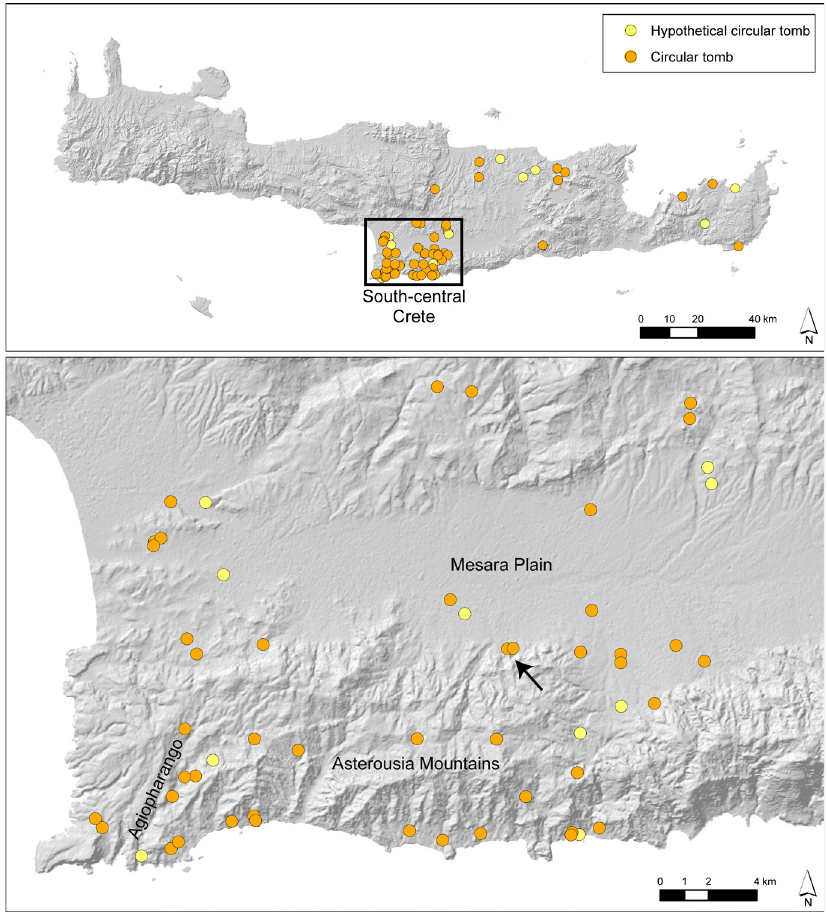
Figure 1. Spatial distribution of cemeteries of circular tombs in Crete. The location of Apesokari is indicated by the black arrow.